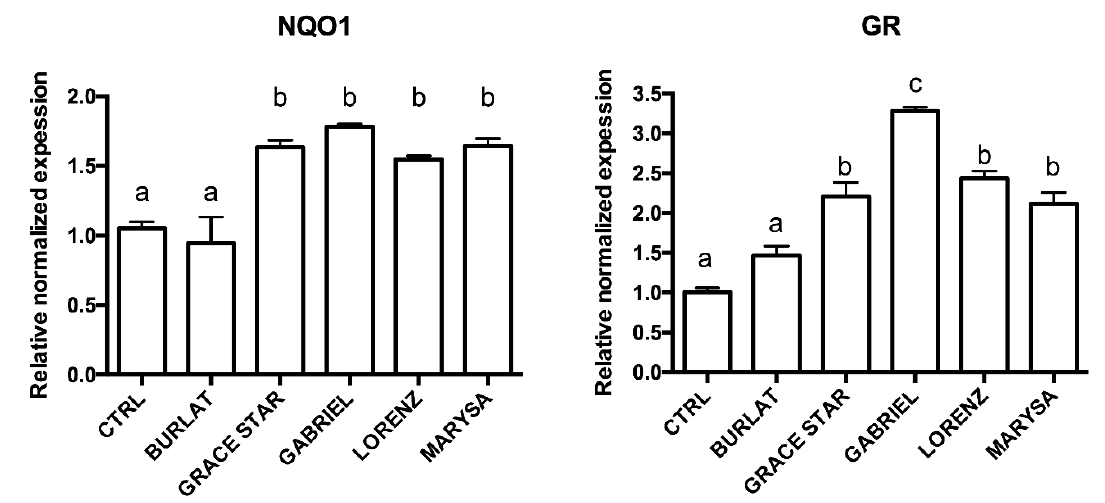
Figure 8. Effect of cherry extracts on the expression of NAD(P)H quinone oxidoreductase (NQO1) and glutathione reductase (GR) in SH-SY5Y cells. Each bar represents the mean ± SEM of at least three independent experiments. Different letters indicate statistical significance ( p < 0.05).